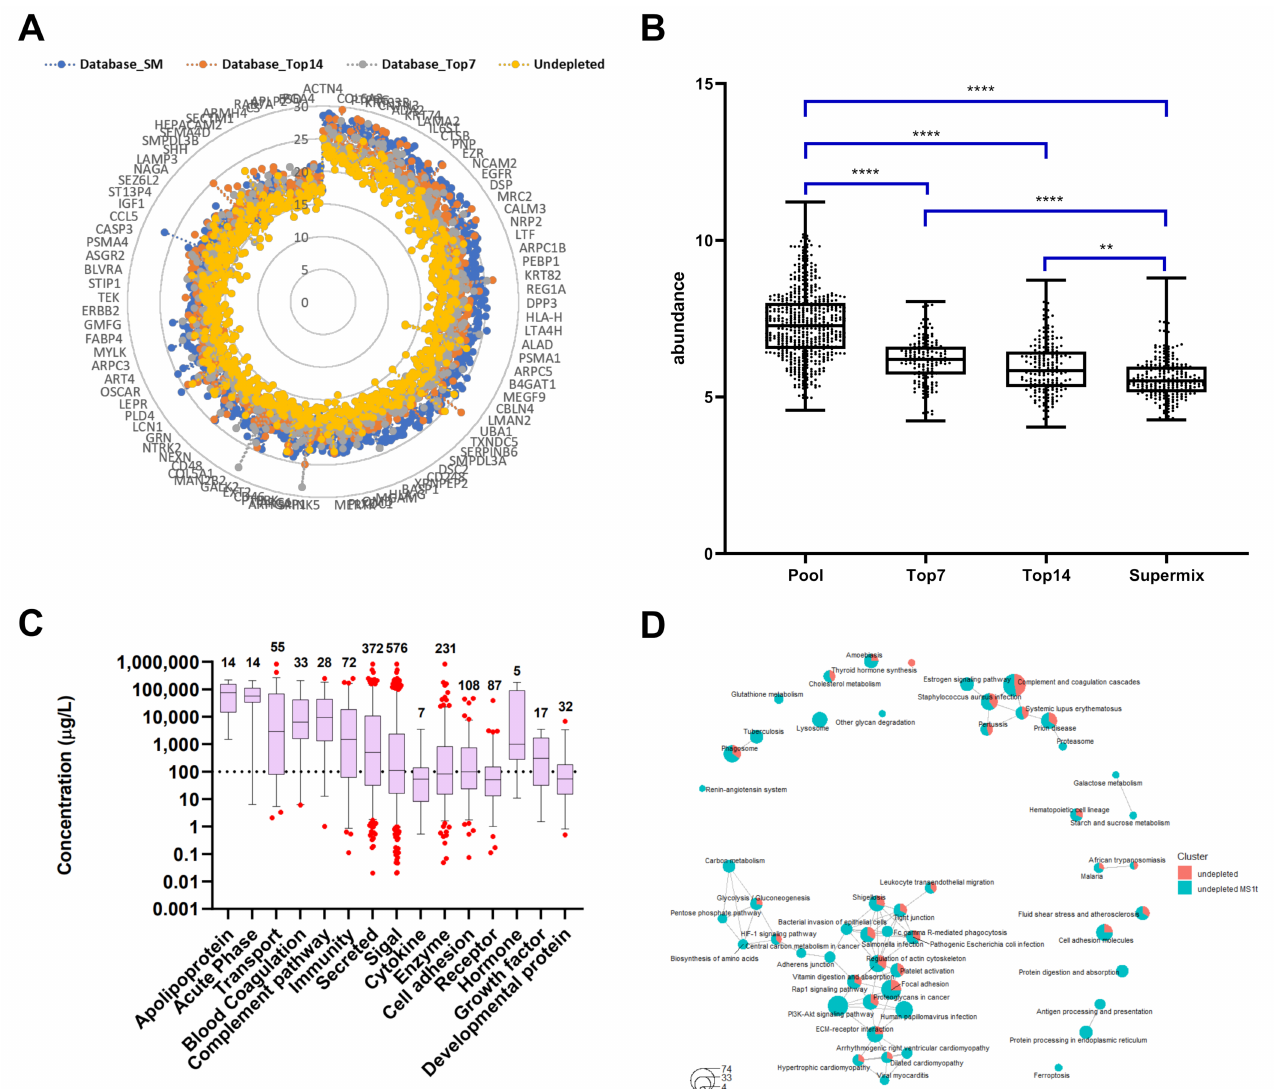
Figure 5. Assessment of proteins identified in undepleted plasma by WiMT. ( A ) A graphic representation of the 4-layer custom database. The layers represent the depletion levels and the intensities of the proteins are represented by colors. ( B ) Protein classification according to their depletion levels. The y axis refers to the protein abundance in undepleted plasma samples. One-way ANOVA test (GraphPad Prism 8.3.1): ** <0.01; **** >0.0001. ( C ) Proteome profiling of undepleted plasma applying MS1t for peptide identification. The proteins were annotated using the information included in The Human Protein Atlas database for plasma proteins (https://www.proteinatlas.org/search/protein_class:Plasma+proteins, accessed on: 29 July 2020) [45–47]. The graphs were built using the protein concentrations in blood reported in the same database. The boxes represent the median and whiskers for the 5th and 95th percentiles, respectively. ( D ) KEGG pathway enrichment analysis for the comparison of undepleted plasma before and after MS1t. Each circle represents a pathway, while the size of each circle is related to the number of proteins, and the colors differ from the results obtained before and after